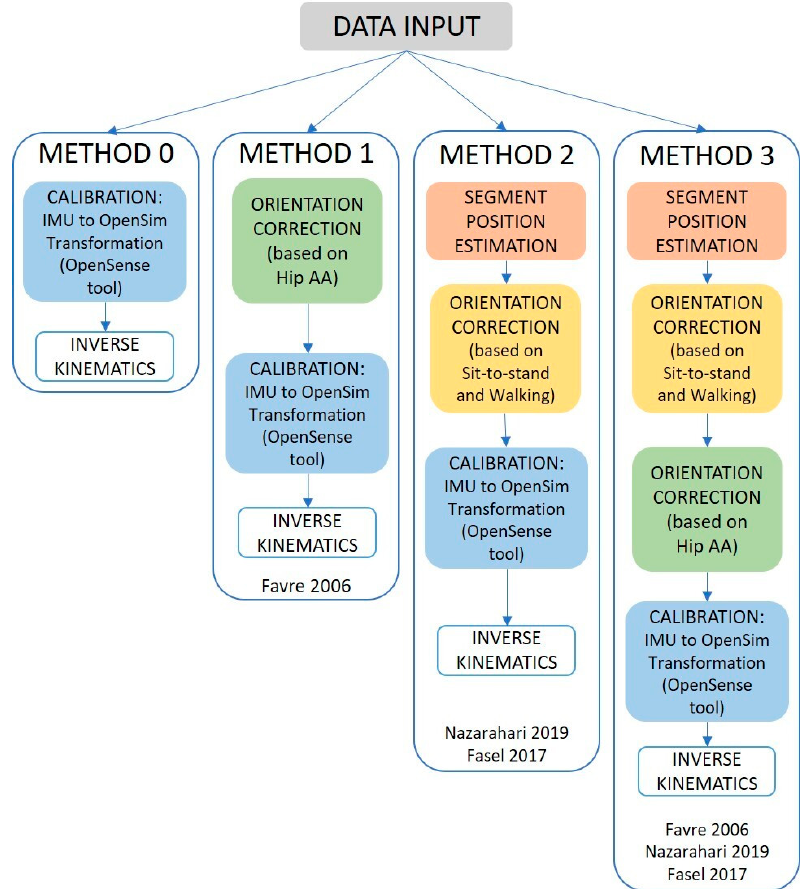
Figure 2. Workflow scheme for the different methods: the green, orange, and yellow boxes are part of the functional calibration and sensors alignment.